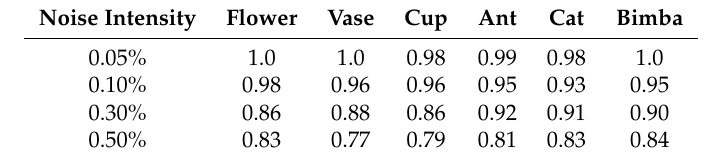
Table 5. Watermark robustness against additive noise measured in terms of correlation.